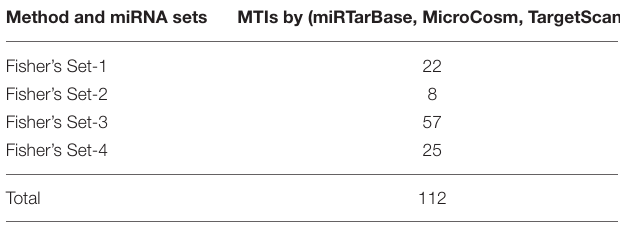
TABLE 4 | CyTargetLinker results of defined number of targets by threshold